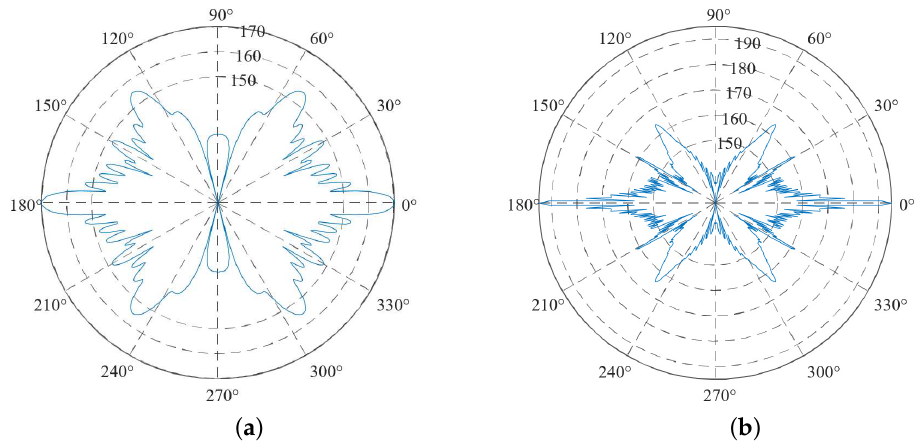
Figure 6. Directive curve of ultrasonic transducer (( a ) single-wafer transducer and ( b ) four-laminated